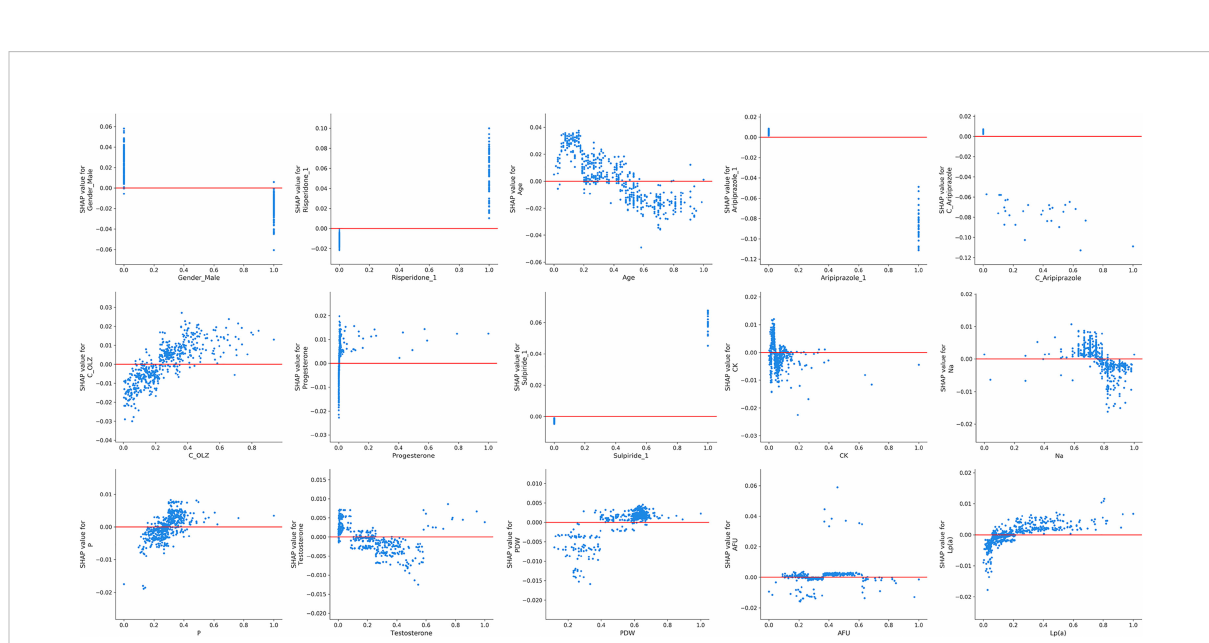
FIGURE 4 The SHAP dependence plots of the top 15 features. The SHAP values that exceeded zero represent high log-transformed PRL values, and vice versa.